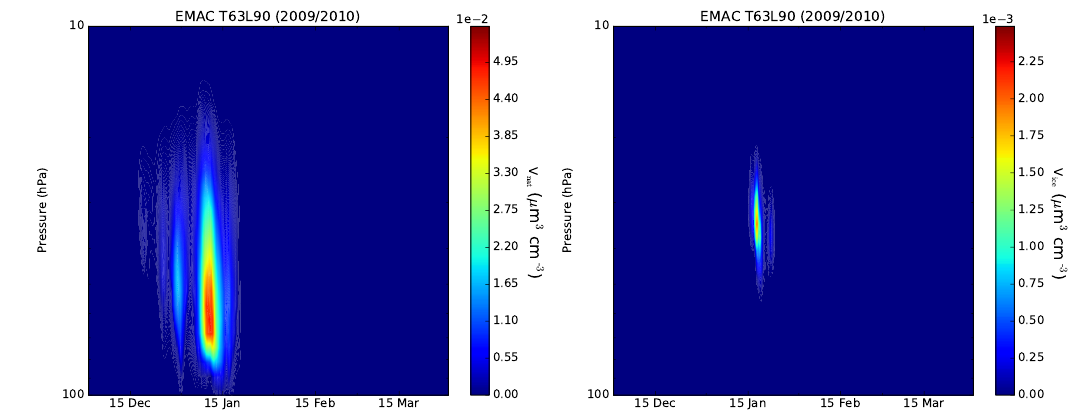
Figure 5. Volume density of solid particles ( V NAT and V ice ) in µm 3 cm − 3 as simulated with EMAC for the Arctic winter 2009/2010.